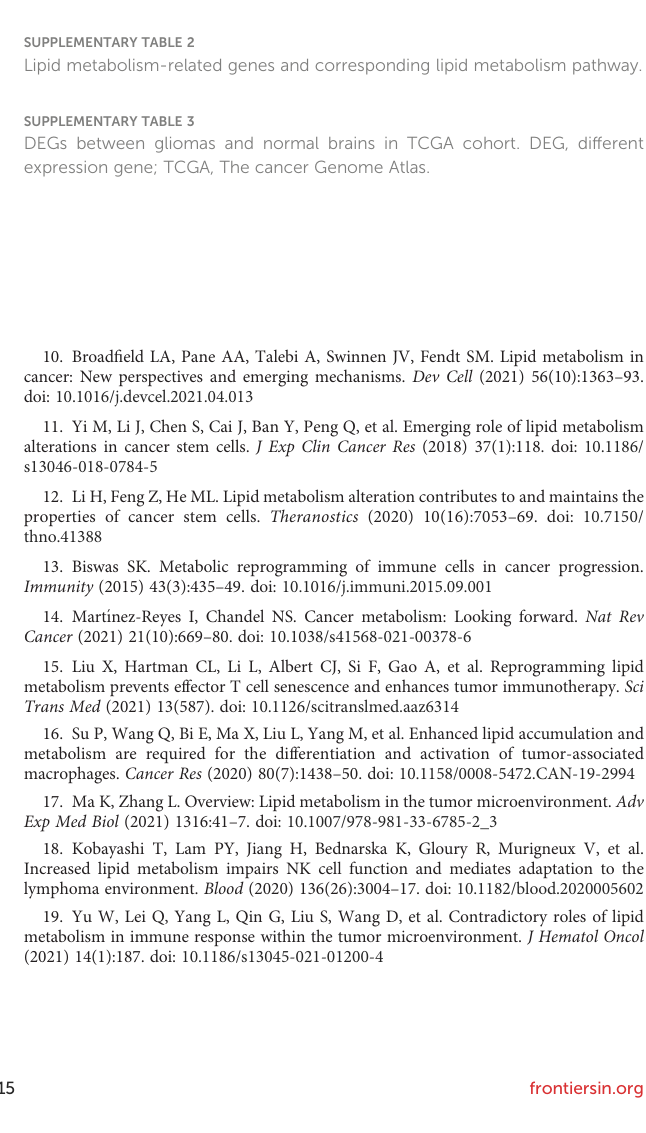
SUPPLEMENTARY TABLE 1 Lipid metabolism -related pathway retrieved from MSigDB. MSigDB, Molecular Signature Database.